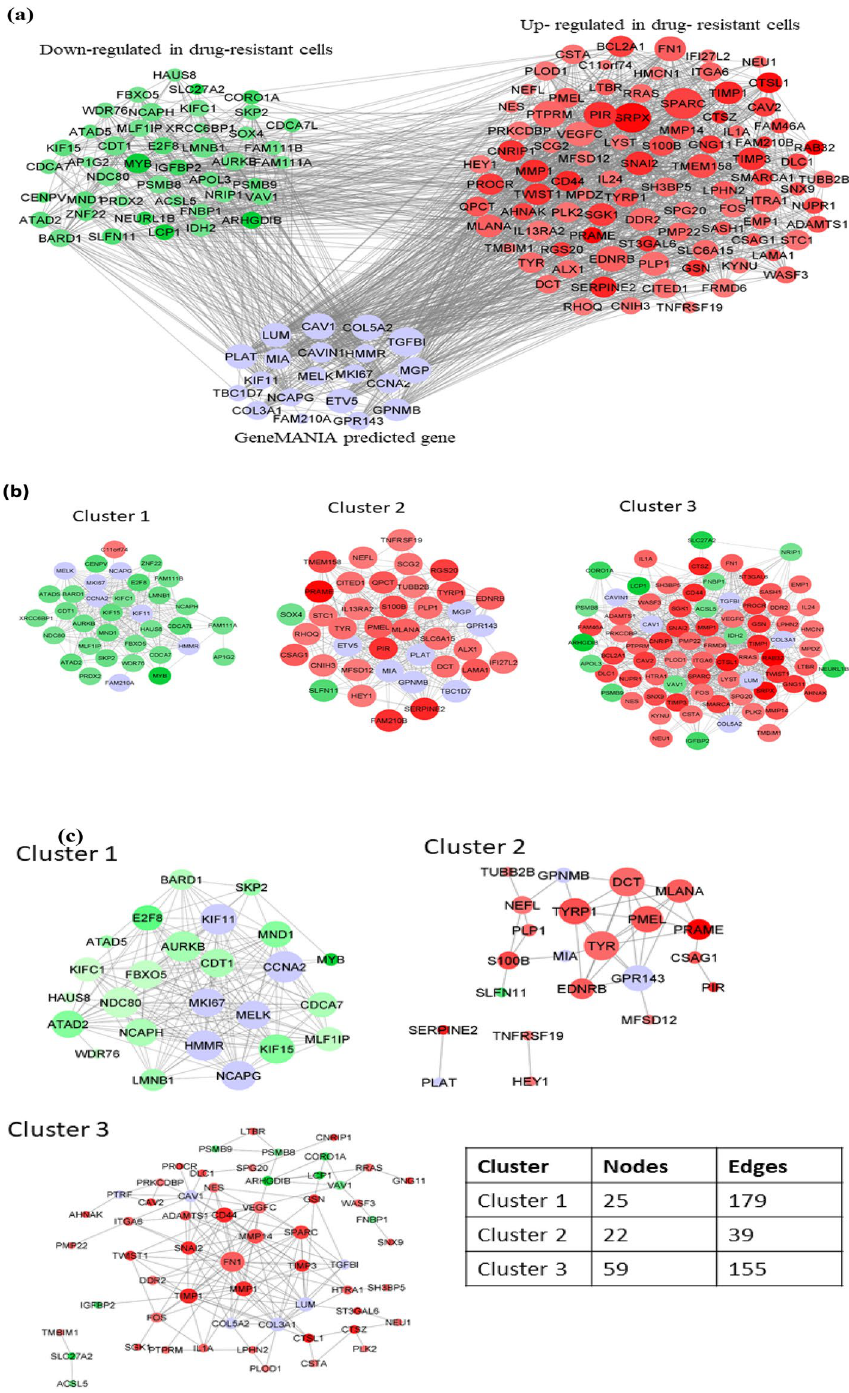
Figure 3. Gene co-expression and PPI network. ( a , b ) Gene co-expression network of DEGs for Ponatinib predicted from GeneMANIA and visualized in Cytoscape. The co-expression network represents up- (red) and down-regulated genes (green) and GeneMANIA-predicted genes (blue); the top hub genes were detected by node degree (node size proportional to node degree) is seen in ( a ); ( b ) depicts Glay generated modules: cluster 1, cluster 2 and cluster 3. C-D: PPI network of clusters. ( c ) Detection of hub proteins by analyzing node degree for Ponatinib (red nodes: up-regulated; green nodes: down-regulated, blue nodes-GeneMANIA predicted). Circle size is proportional to the node degree. ( d ) Venn diagram of common hub protein-coding genes identified across the drugs. ( e ) Diagrammatic representation of the interconnectivity of topmost genes FN1 and CD44 in RAS and PI3K/Akt signaling pathways taken from KEGG. Dashed arrows represent several other proteins involved in signaling. Data are taken from KEGG Pathways (CD44 in signaling: https:// www. kegg. jp/ kegg- bin/ highl ight_ pathw ay? scale=1. 0& map= map05 205& keywo rd= cd44; FN1 in signalling: https:// www. kegg. jp/ kegg- bin/ highl ight_ pathw ay? scale=1. 0& map= map04 151& keywo rd=